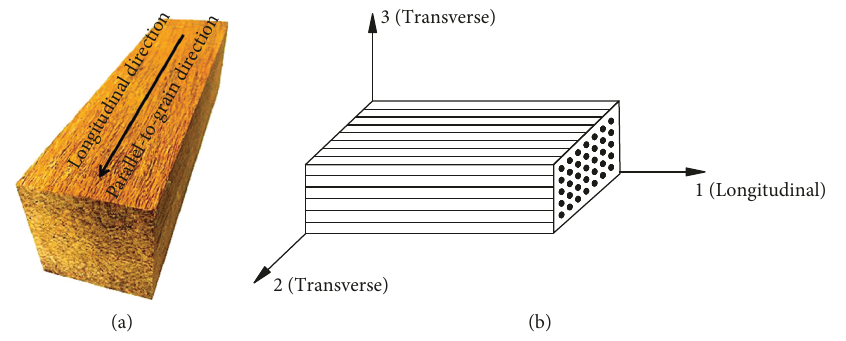
Figure 1: (a) Photograph of PSB. (b) Principal directions of